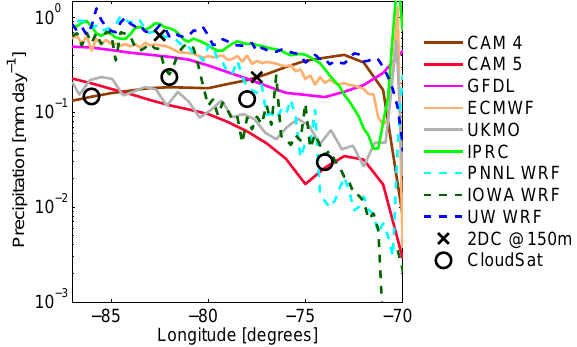
Figure 6. Mean surface precipitation (in mmday − 1 ) along 20 ◦ S compared with leg-mean precipitation rate from C-130 estimates at 150m using a 2D-C probe, and with CloudSat climatology for October–November 2007–2010. The 2D-C precipitation mean for 70–75 ◦ W is less than 0.001mmday − 1 and not